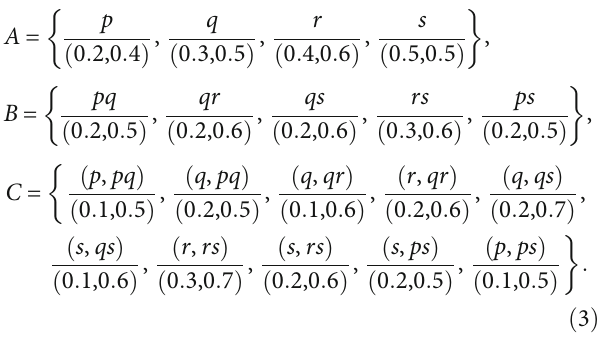
Figure 1: Incidence graph G ∗ .